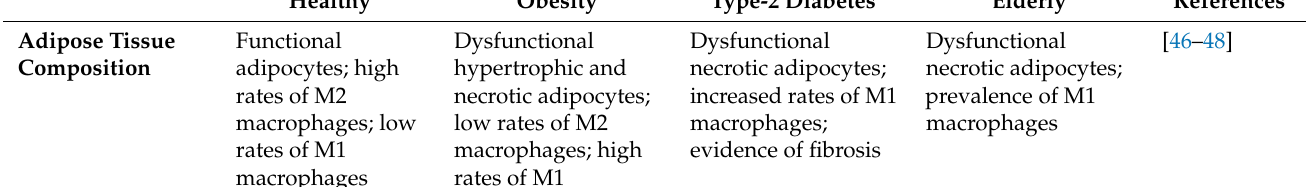
Table 1. Comparison of the immune responses to influenza vaccination in healthy vs high-risk populations. These differences correspond to changes in influenza vaccine